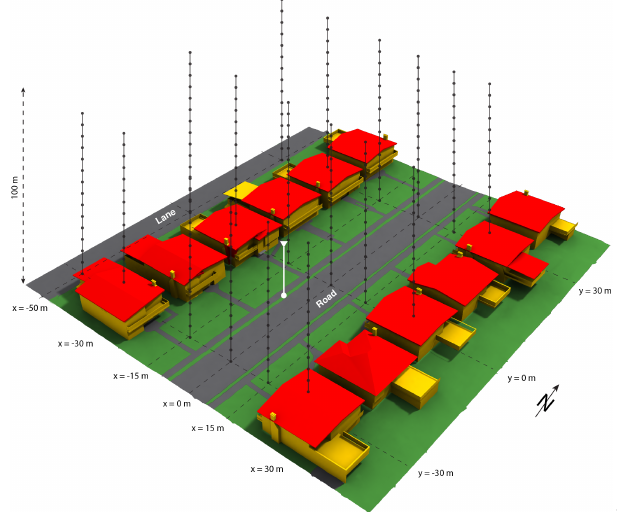
Figure 3. Rendering of the modelled urban canyon with facet clas- sifications (roofs: red, walls and other building structures: yellow, lawns: green, roads and pathways: grey), location of the hydraulic mast (white line) and the thermal camera (white triangle). The verti- cal black dots refer to the 270 simulated positions of hemispherical radiometer locations (see Sect.